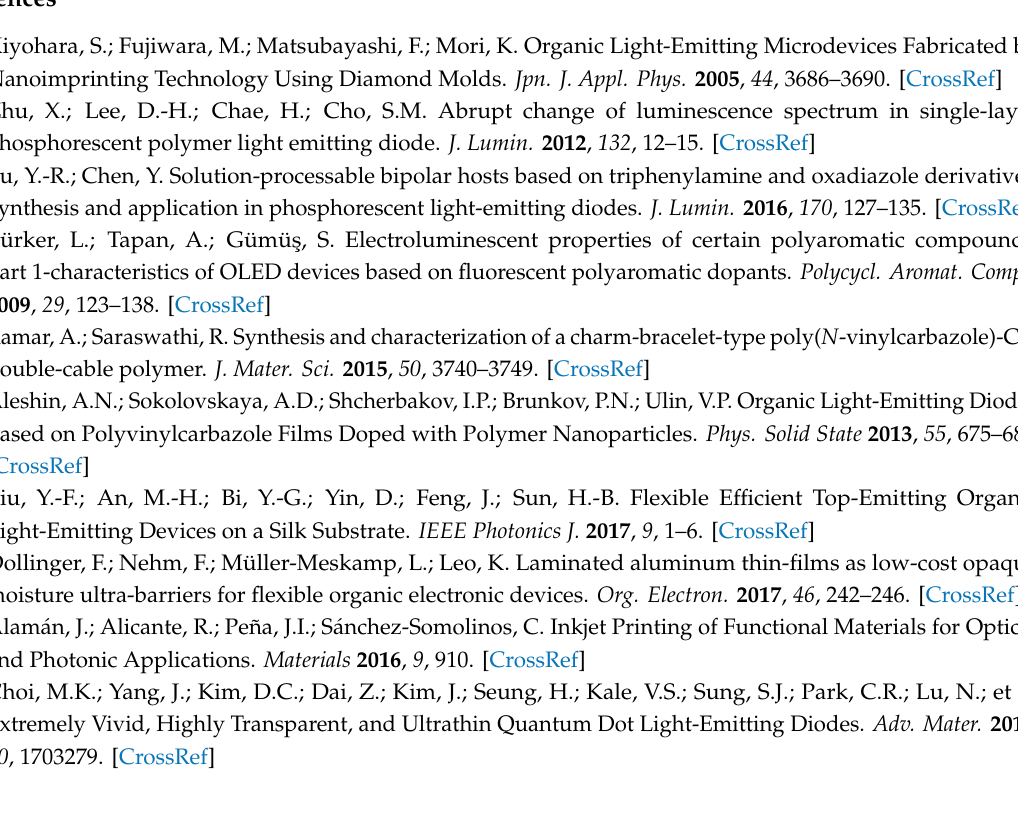
Figure S1: Electroluminescent behavior of the hybrid LED with PVK:CdS NCs [1:0.5] as a function of voltage. Voltage increasing from 12 to 17 V, Figure S2: CIE coordinates of the hybrid LEDs with increasing CdS content: PVK (circle), PVK:CdS [1:0.5] (diamond), PVK:CdS [1:1] (triangle) and PVK:CdS [1:2]